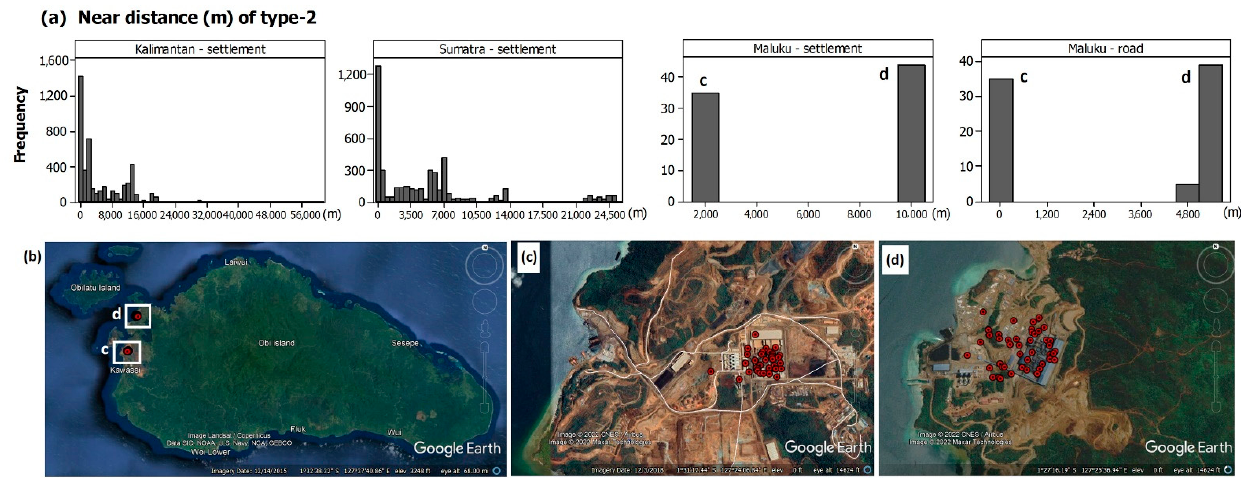
Figure 6. ( a ) The histogram distribution for near-distance analysis between type-2 data to the settle- ment areas in Kalimantan, Sumatra, and Maluku, and near distance of type-2 to the roads in Maluku; ( b ) the spatial location for type-2 data in Maluku overlaid on high spatial images from Google Earth; ( c ) enlarged image for the first hotspot cluster (red dots) situated in industrial mining area with GIS road features (white lines); ( d ) enlarged image for the second hotspot cluster (red dots) in industrial mining area; no road features. Both hotspot clusters located in coastal areas.